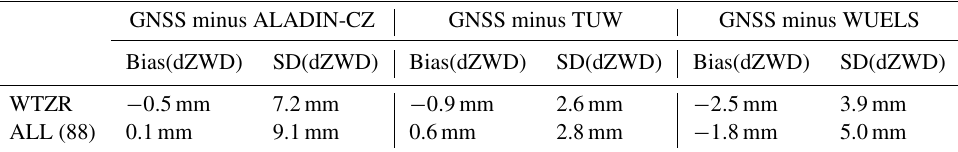
Table 4. Statistics of the differences in ZWD for GNSS site WTZR and all 88 GNSS sites within the study domain. The reference solution (GNSS) was obtained by parameter estimation using GNSS phase measurements. The ALADIN-CZ, TUW set1 and WUELS set1 were computed by vertical integration through the wet refractivity fields: Analysed period: 29 May until 14 June